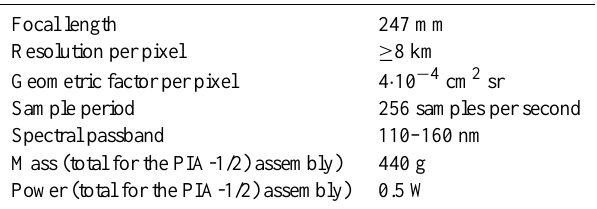
Table 2. PIA-1/2 instrument characteristics Focal